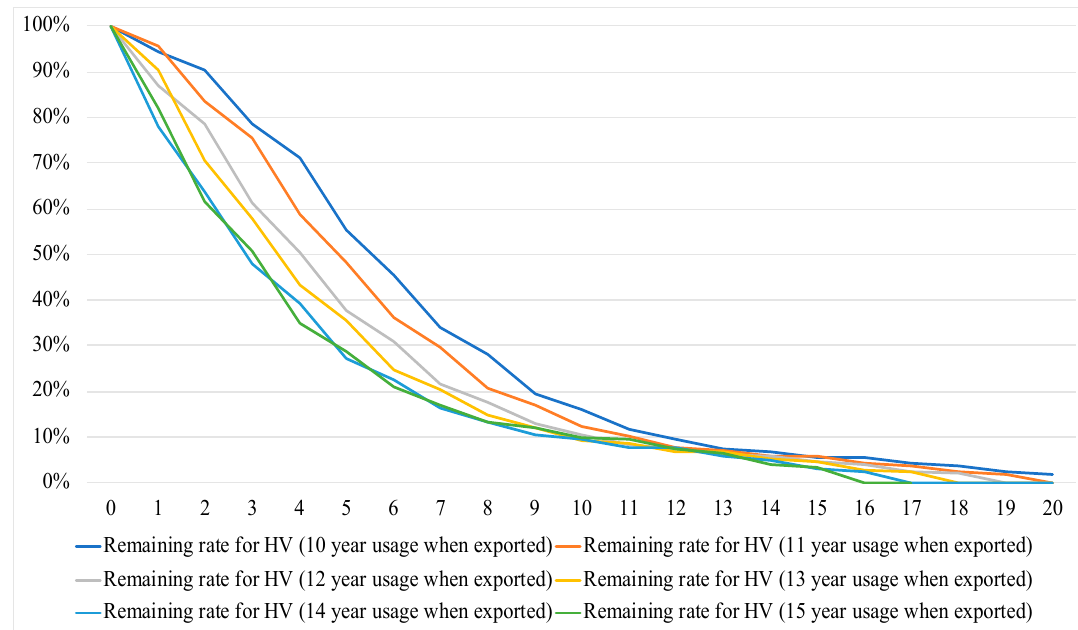
Figure 9. The remaining rate for exported secondhand HV of each year. Source: Figure made by the author based on Automobile Inspection & Registration Information Association ′ s data [20].